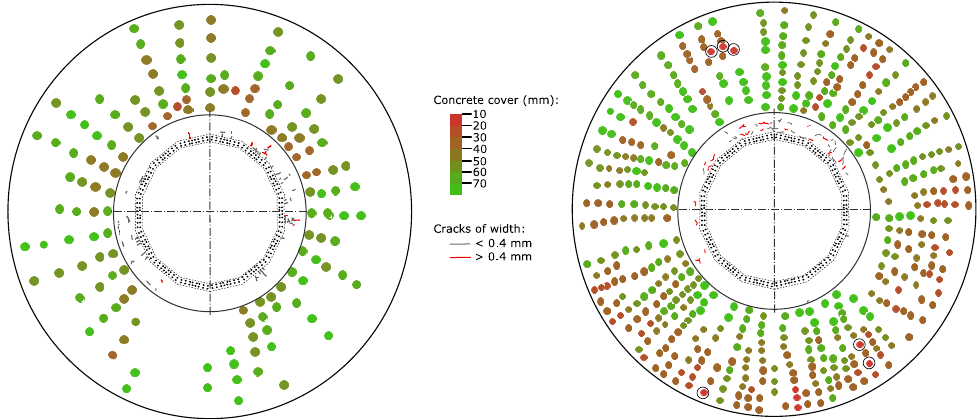
Figure 8. Concrete cover measures on the inclined surface and crack patterns on the horizontal pedestal surface.